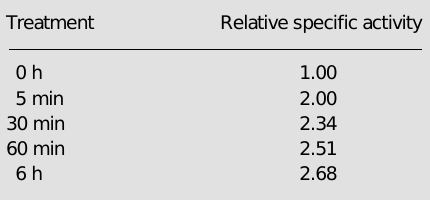
Table 2 - Effects of UV-B pulses on specific activ- ity of NADP-ME from etiolated maize seedlings.